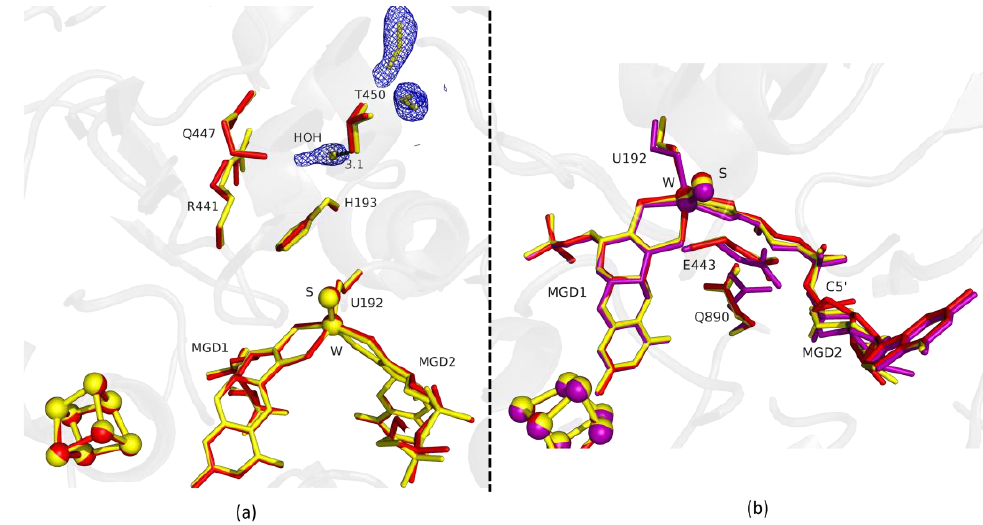
Figure 2. Superposition of Dv FdhAB as-isolated (red), formate-soaked Fdh_1.5min structure (yellow), and formate reduced (violet) (in b ) in two different orientations. ( a ) U192, H193, R441, Q447, T450 and the two MGD co-factors are shown as sticks, along with two formate molecules and one water molecule present in the formate tunnel of Fdh_1.5min. The 2fo-fc map is shown as a blue mesh, at 1.0 σ . The distance between the water molecule and T450 O γ is indicated in Å. ( b ) U192, E443, Q890 and the two MGD co-factors (note the C5 (cid:48) atom of MGD2) are shown as sticks.